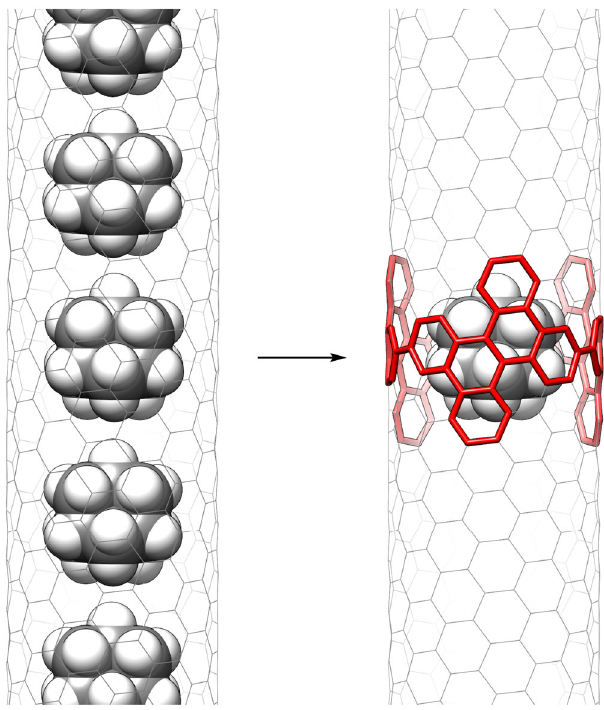
Fig. 1 Hybrid nanocarbon peapods between sp 2 - and sp 3 nanocarbons. A structure of adamantane molecules trapped in a (9,6)-helical CNT (left) and a segmental model molecule in this study (right) are shown.